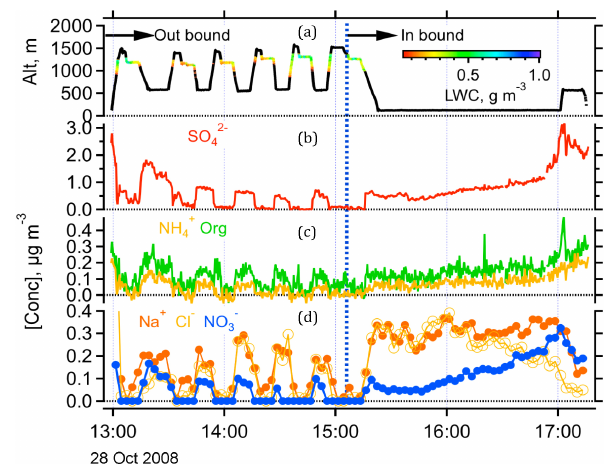
Figure 3. Time plots of altitude and aerosol chemical concentra- tions measured on the 28 Oct 2008 flight. The aircraft altitude plot is color-coded to the liquid water content of clouds encountered dur- ing the out-bound leg (a) ; the blue dotted vertical line marks the time when the G-1 turned around and headed back to